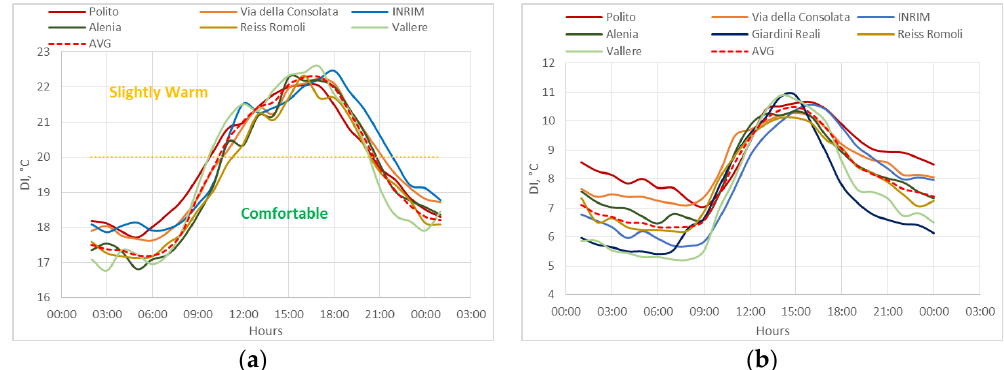
Figure 23. Discomfort Index (DI): ( a ) 25 August 2016 ( b ) 21 January 2016.